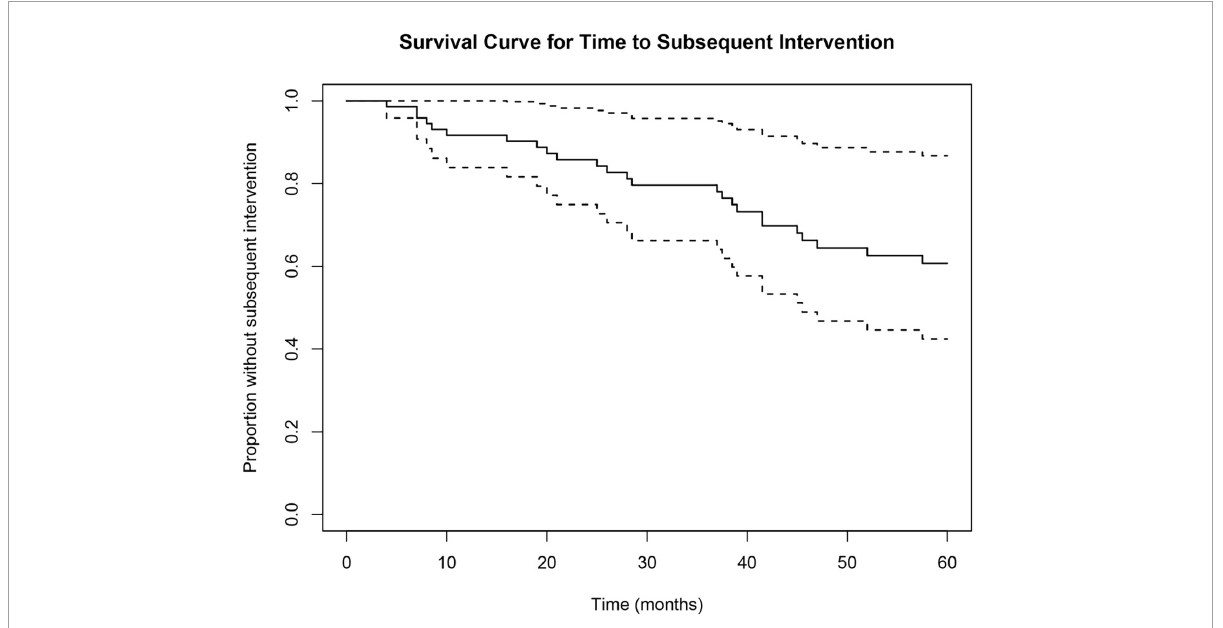
FIGURE2 Cox proportional hazard survival curve for time to subsequent surgical intervention. Survival analysis showed a 79.6% survival probability at 36 months and a 60.7% survival probability at 60 months. Dotted lines represent upper and lower 95% confidence intervals.